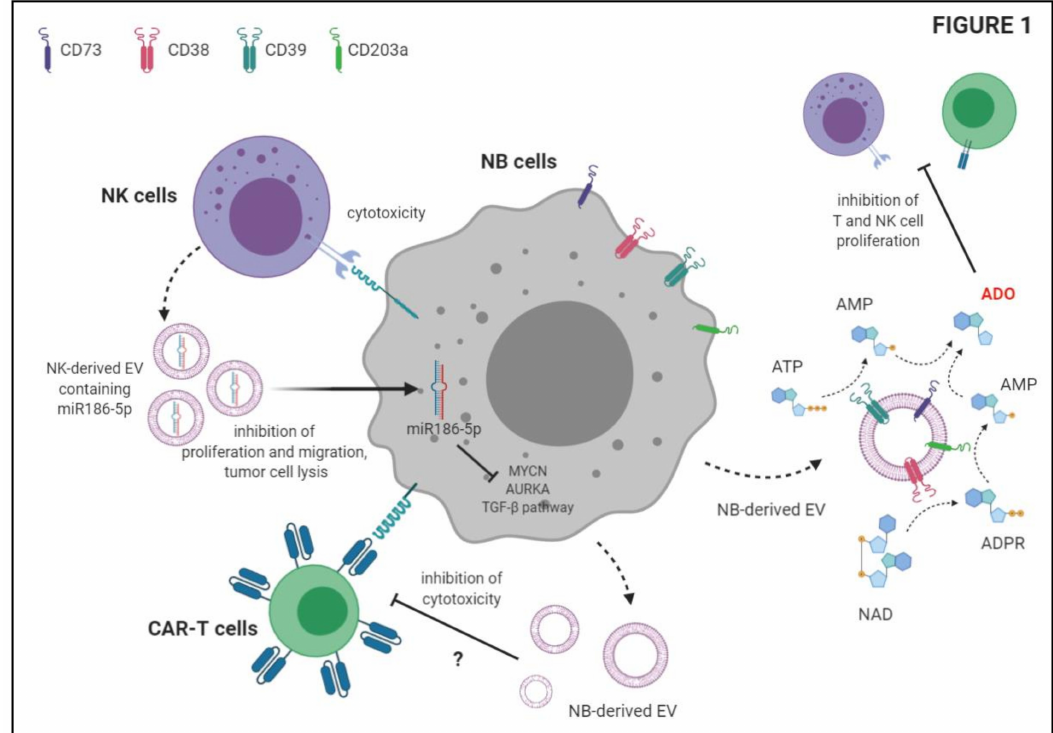
Figure 1. Schematic depiction of the immunosuppressive functions of Neuroblastoma-derived extracellular vesicles (EV) and anti-tumor activities of NK-derived